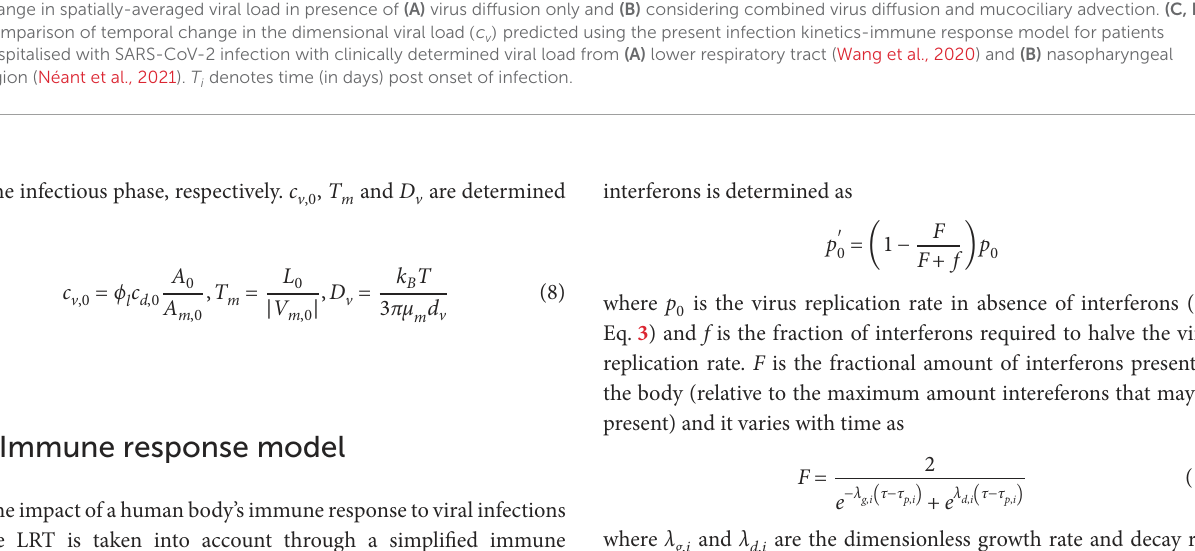
, T and D are v ,0 m v